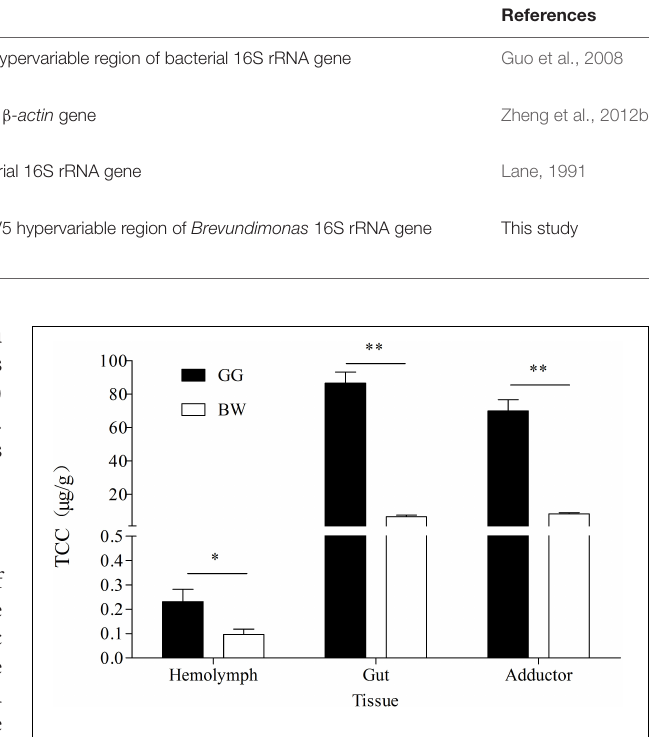
FIGURE 2 | TCC in hemolymph, gut and adductor of golden and brown noble scallops. Date are shown as the mean ± SD ( n = 5). ∗ P < 0.05; ∗∗ P < 0.01 ( t